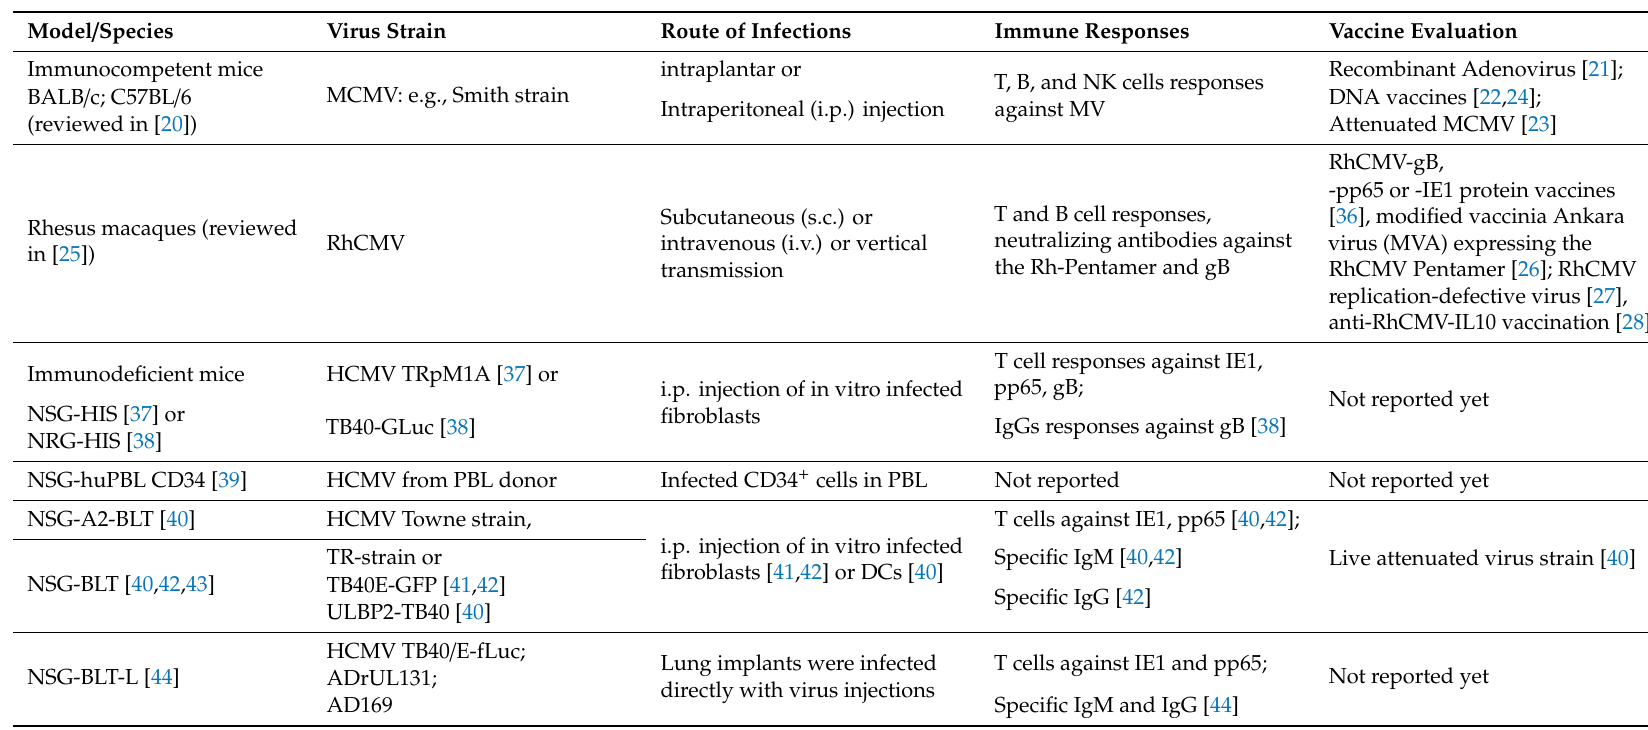
Table 1. Di ff erent modalities of in vivo models of CMV infection and their uses for vaccine testing purposes. Mouse CMV (MCMV), rhesus CMV (RhCMV), and human CMV